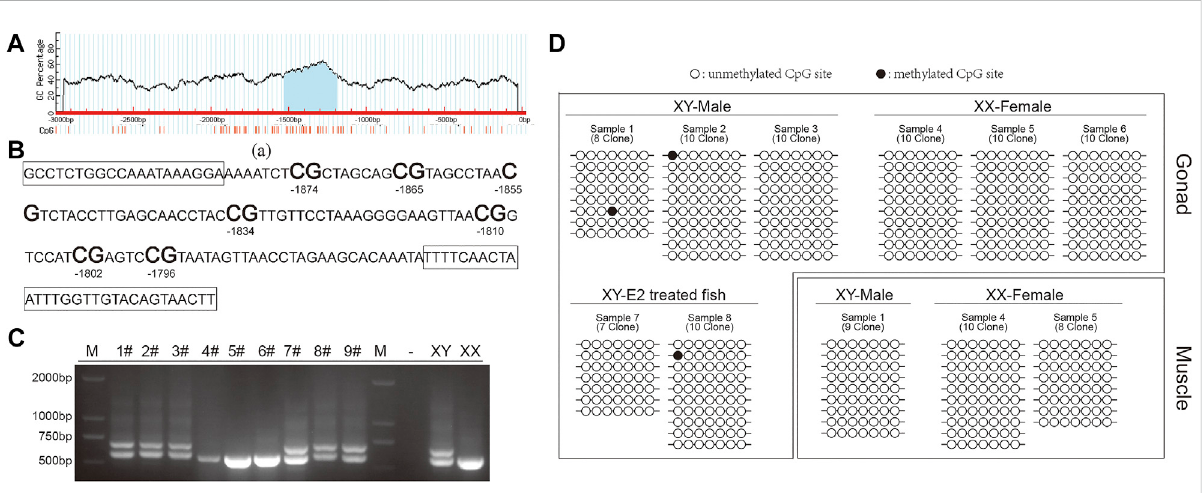
DNAmethylationinthe 42Sp50 promoter. (A) ThepredictionofCpGislandin 42Sp50 promoter. (B) Thefragmentof 42Sp50 promoterselected in this study. The primers are marked with boxes. (C) The identi fi cation of genetic sex of E2 treated fi sh. (D) The site methylation level was analysed. Black solids and circles correspond to methylated and unmethylated sites, respectively.